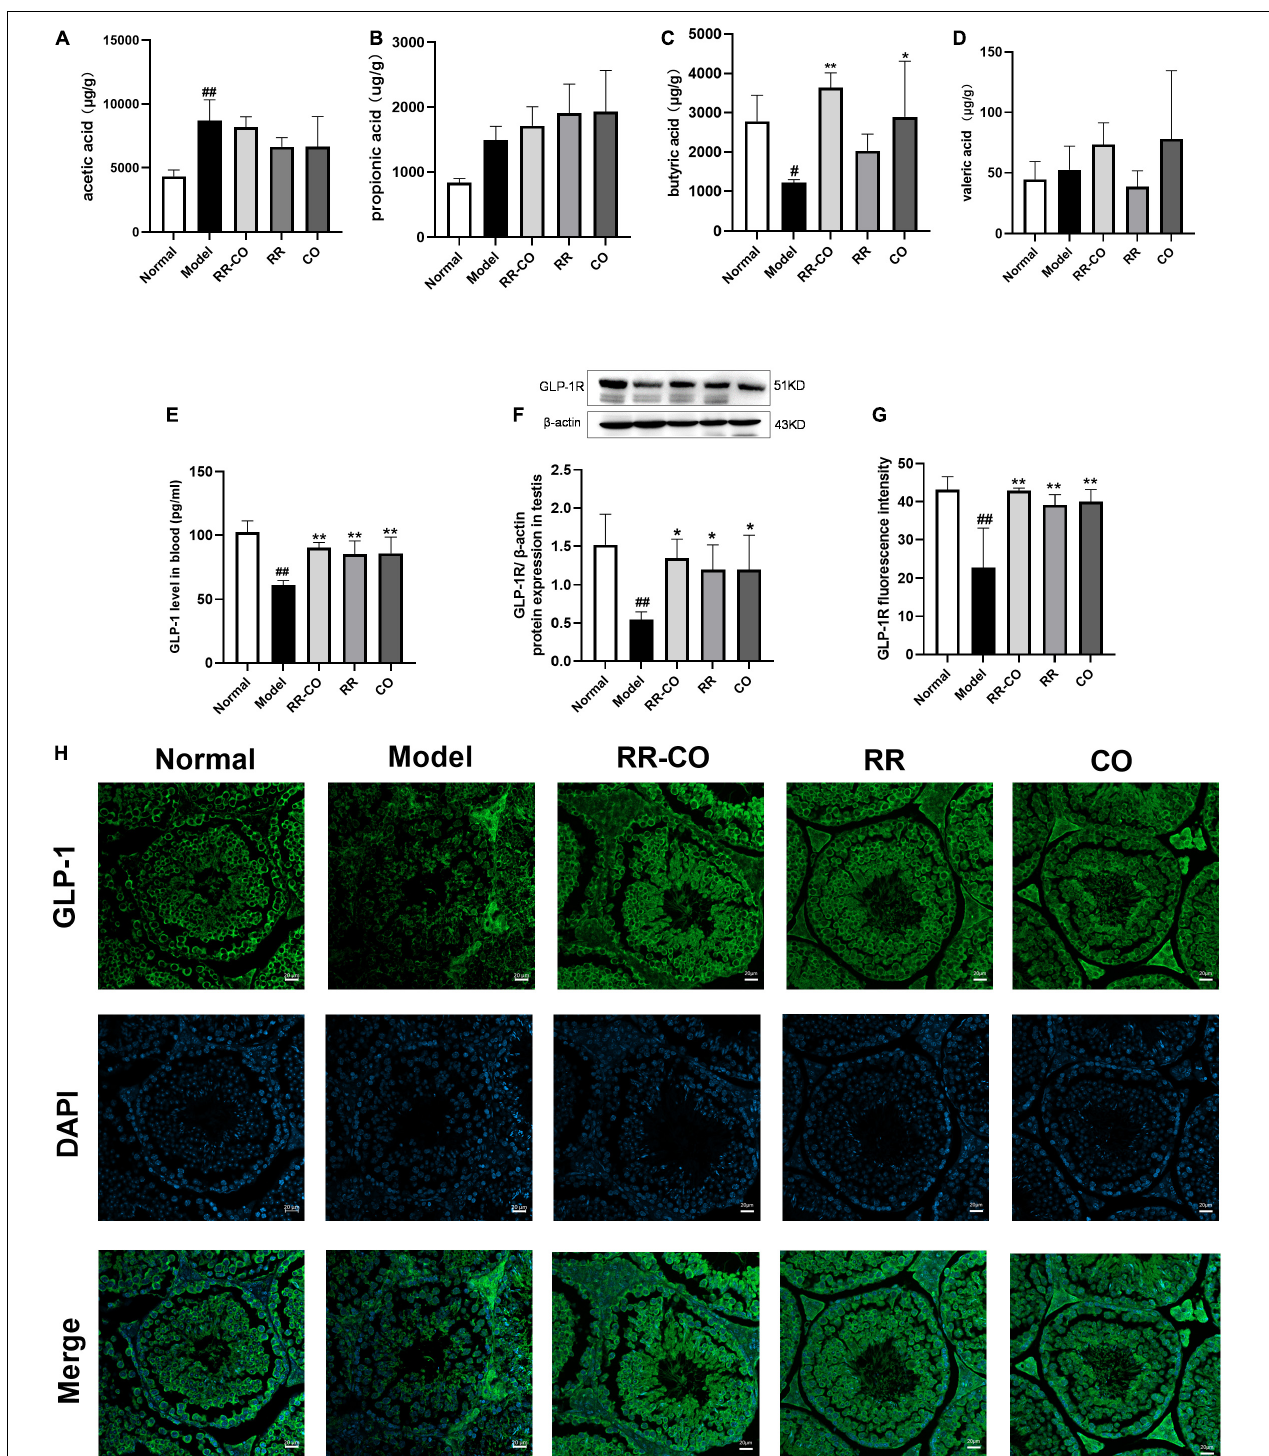
FIGURE 7 | The effects of RR-CO treatment on the SCFAs/GLP-1 axis. (A–D) Acetic acid, butyric acid, propionic acid, and isovaleric acid levels in feces ( n = 5). (E) GLP-1 level in blood measured using ELISA ( n = 4). (F) The expression of GLP-1R in testis measured using western blotting ( n = 3). (G,H) Fluorescence intensity of GLP-1R in testis ( n = 3). Scale bar, 20 µ m. Data are expressed as mean ± SD. # P < 0.05; ## P < 0.01 vs. normal group. * P < 0.05; ** P < 0.01 vs. model